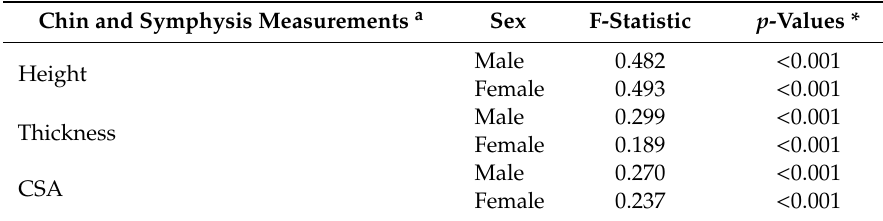
Table 8. Variation comparison of the chin and symphysis parameters in males and females (males n = 203, females n = 216).